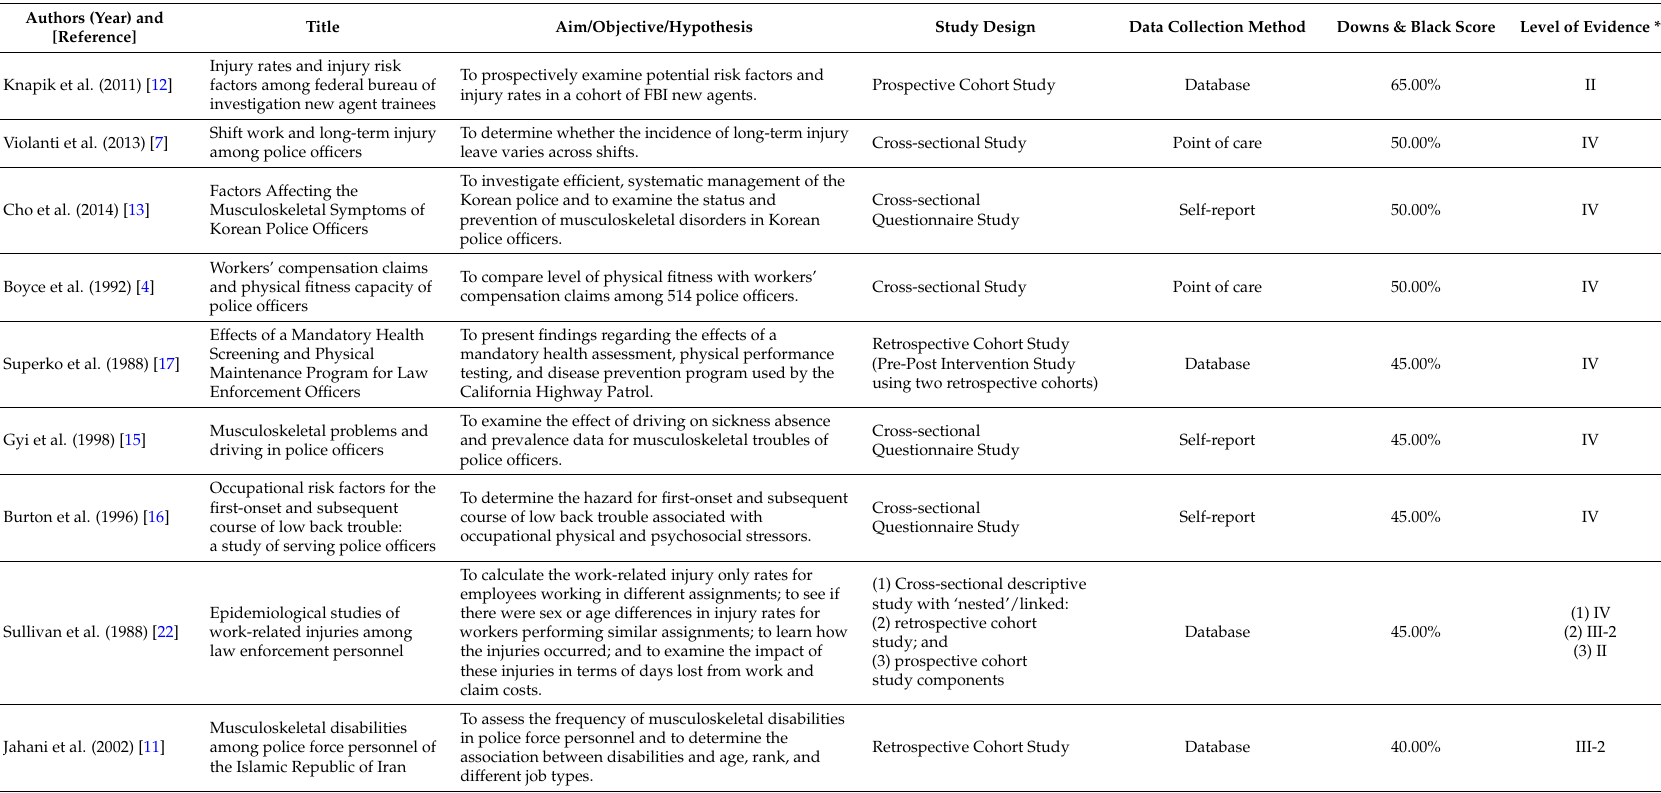
Table 4. Key information regarding the design, aims, data sources, critical appraisal score and levels of evidence of each included study. Authors (Year) and